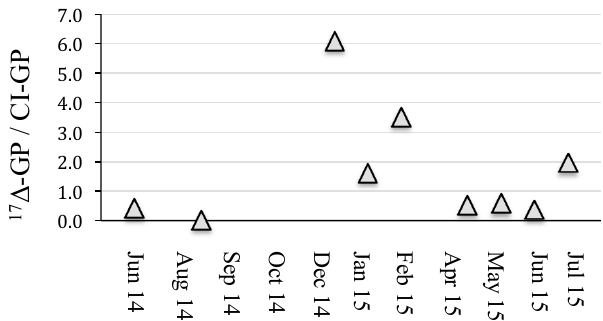
Figure 7. The relative difference between production rates obtained from mixed-layer model ( 17 (cid:49) –GP, following Luz and Barkan, 2000) and our whole column inventory approach